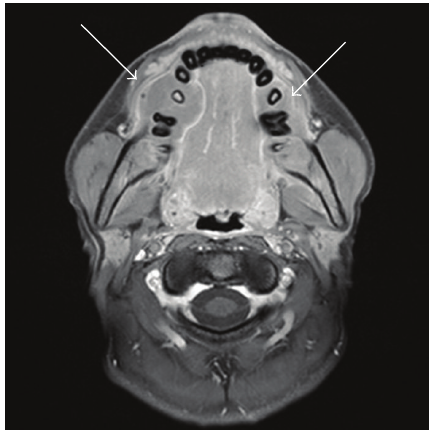
Figure 3: Axial T1 and T1 FS after contrast, demonstrating isoin- tense, enhancing mandibular masses, cortical erosion, and adjacent soft tissue mass.